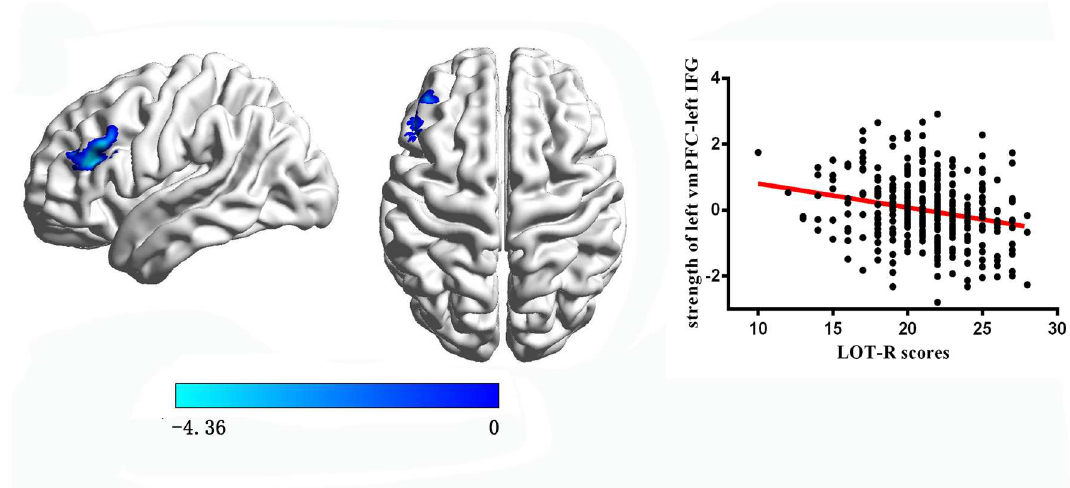
Fig 3. The correlations between optimism and the RSFC with the left vmPFC (without global signal regression). The regions and partial correlations scatterplot of negativeassociationof optimism and the strength of RSFC betweenthe left vmPFC and left